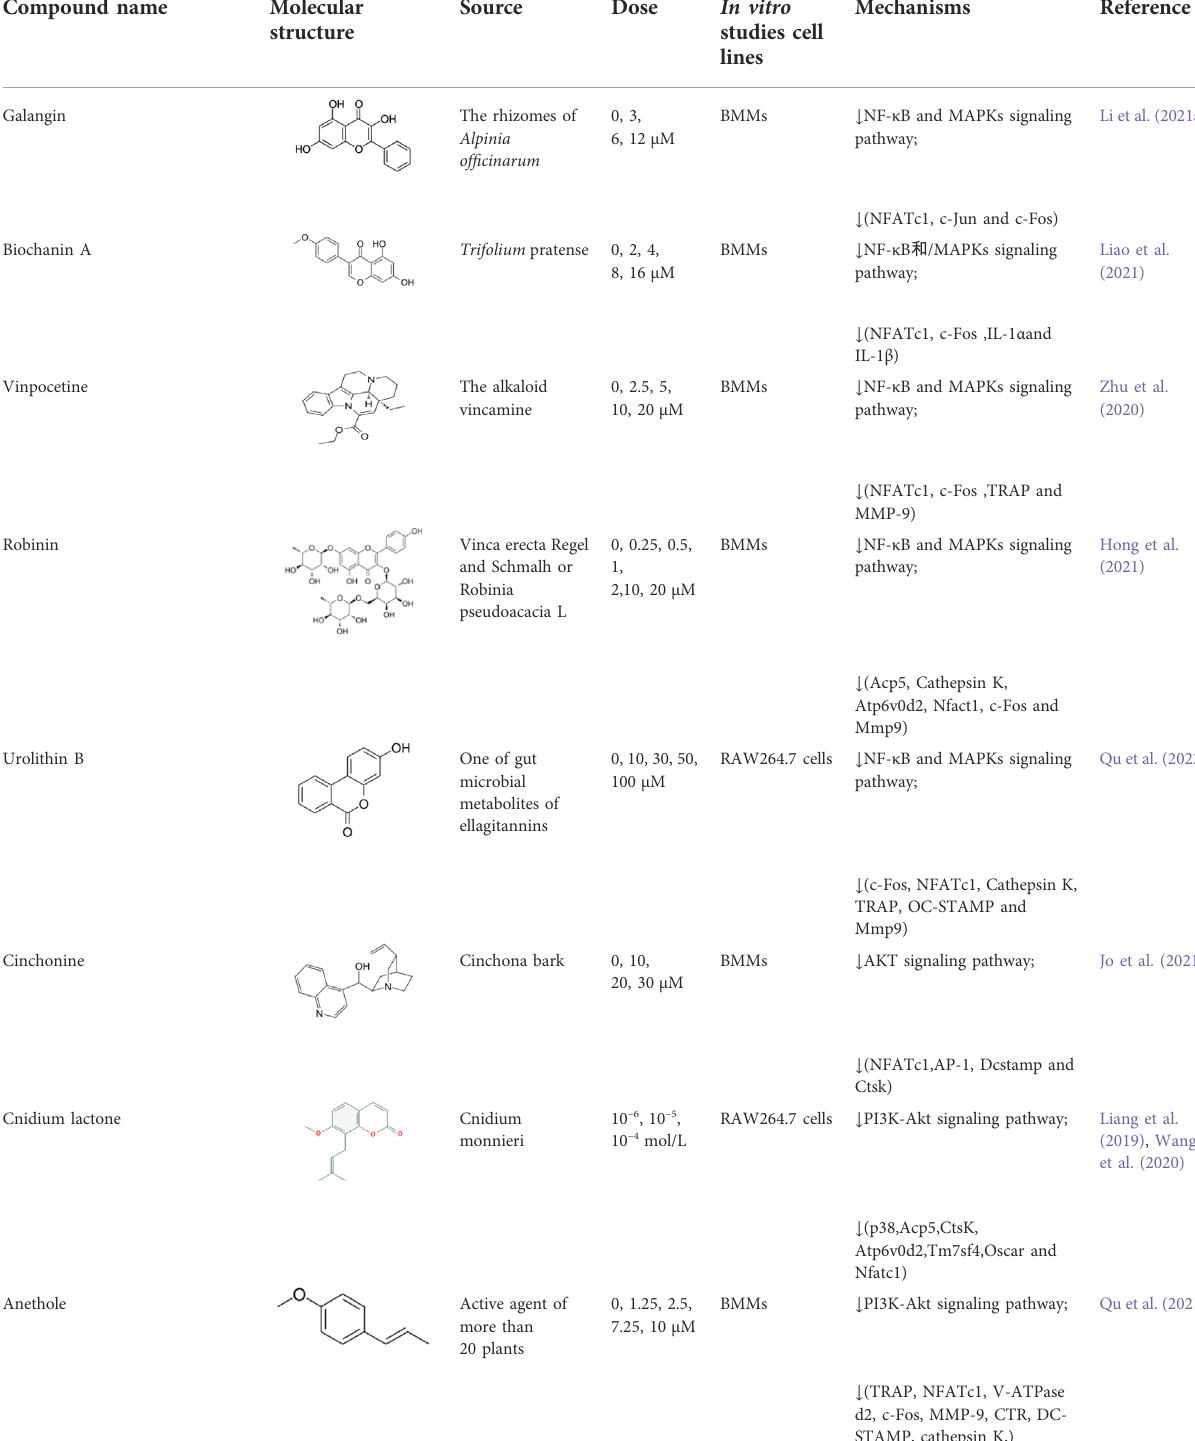
TABLE 1 The source, molecular structure, dose, cell lines and mechanism of 20 natural compounds on modulating osteoclat